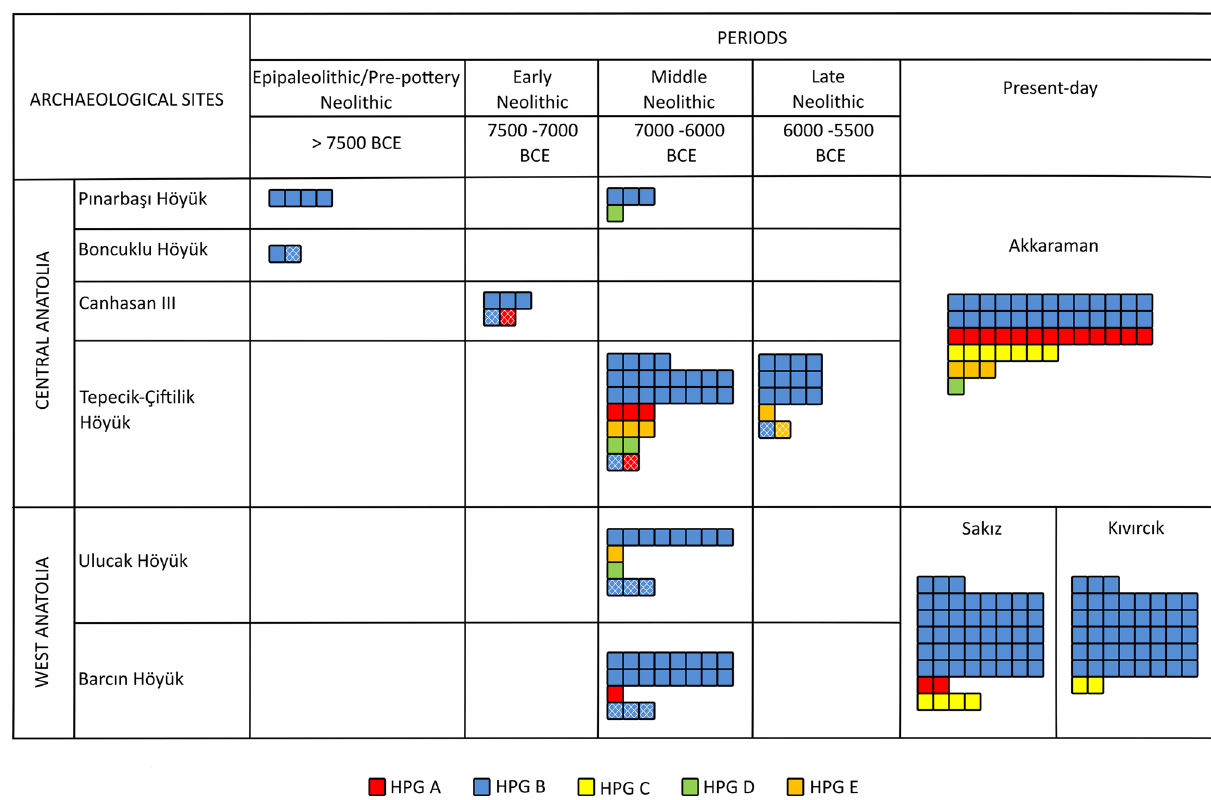
Fig. 4 Change in mitochondrial lineages from Epipaleolithic to present-day in Anatolia. Distribution of different haplogroups (HPG) (indicated by colors) of the studied sheep individuals. Color coding is as follows: HPG A (red), HPG B (blue), HPG C (yellow), HPG D (green), and HPG E (orange). The hatched pattern indicates individuals supported by a single sequence. Note that different periods and haplogroups are not homogeneously represented across different sites from a single region: e.g., >7500 BCE in central Anatolia is represented by P ı narba şı and Boncuklu Höyük, while 7500 – 7000 BCE by Canhasan III. See Supplementary Data 1 for full details. For the samples with ages straddling two periods, we used their mean age to place them within an archaeological period. Haplogroup compositions of present-day breeds of Turkey were represented by Akkaraman (central Anatolia) and by Sak ı z and K ı v ı rc ı k (west Anatolia) (see Supplementary Table 4). Mitochondrial DNA haplotypes of ancient individuals are represented in Supplementary Fig.